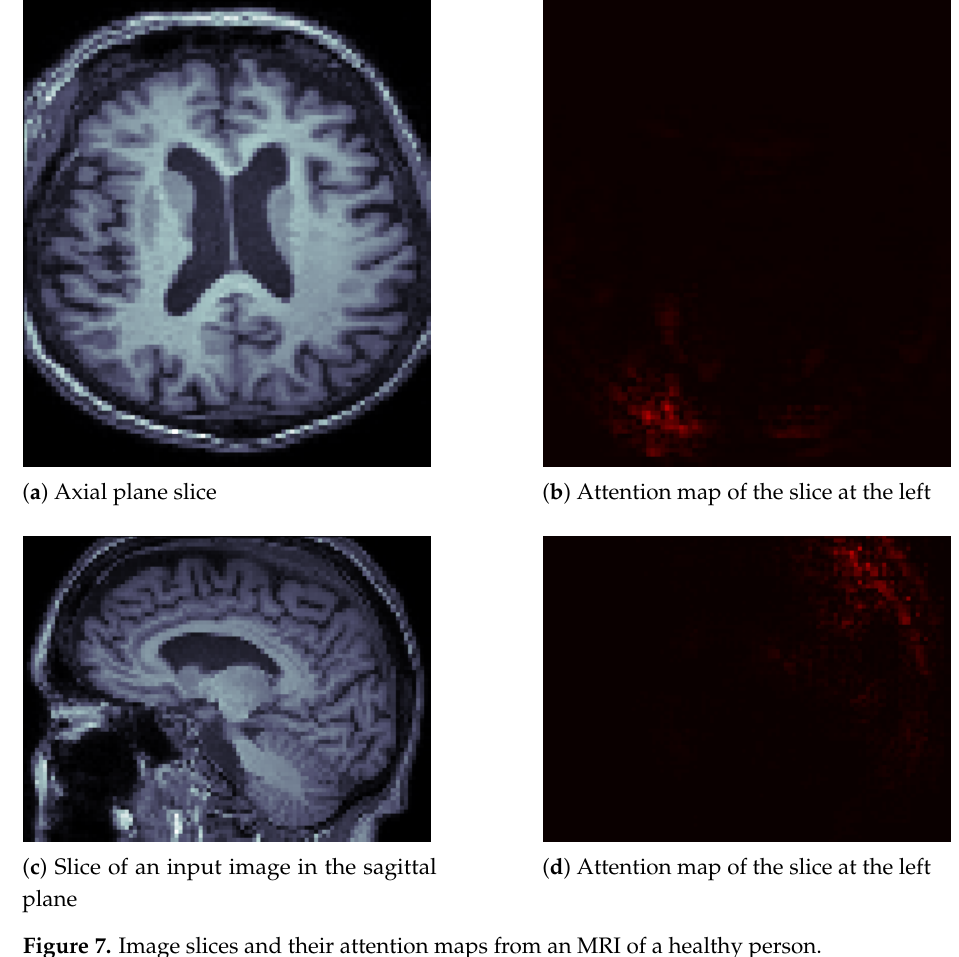
Figure 7. Image slices and their attention maps from an MRI of a healthy